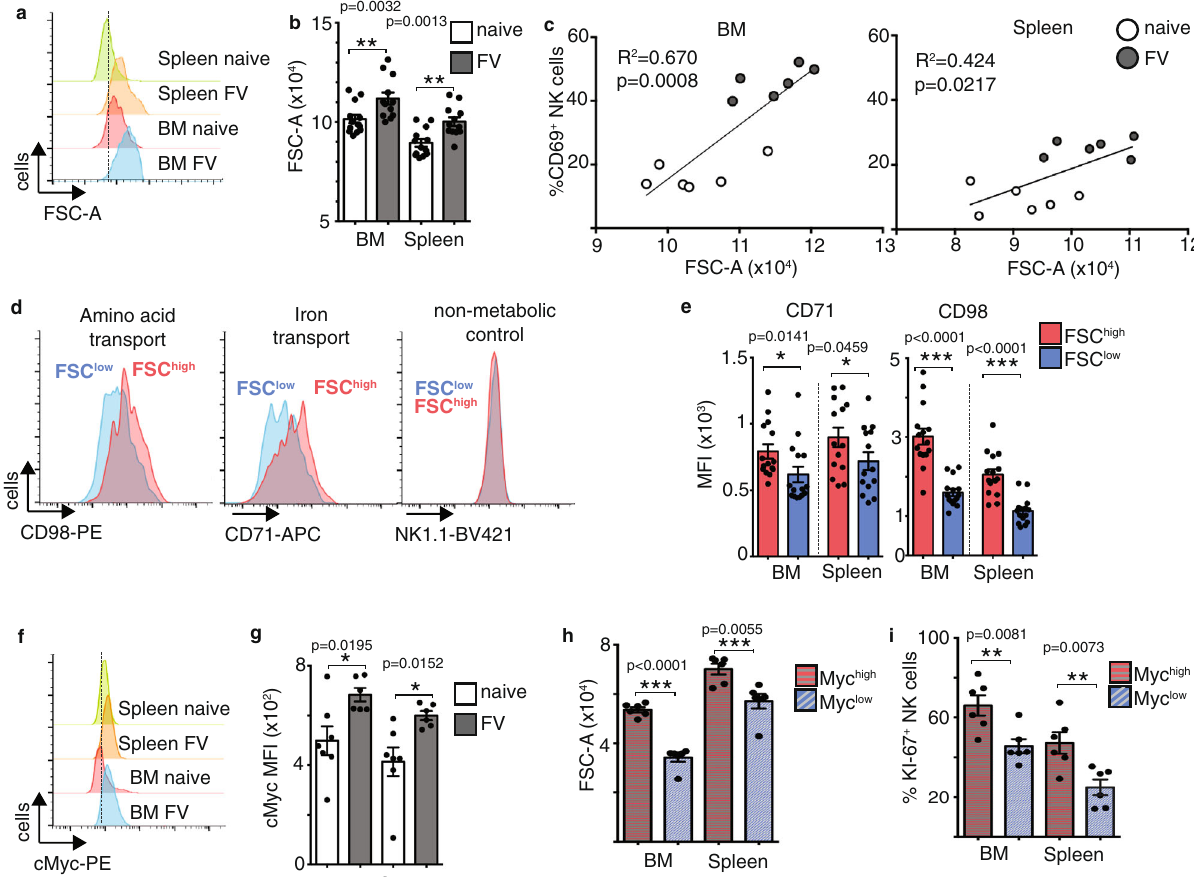
Fig. 2 Increased NK cell blastogenesis and augmented metabolic activity after acute FV infection. Splenic and bone marrow (BM) NK cells from naive mice or mice FV-infected for 7 days were analysed for cell size by analysing the FSC on NK cells. NK cells were gated on lymphocytes, single cells, viable, CD3 − , NK1.1 + CD49b + cells. A representative histogram of the FSC on NK cells from both organs are shown in a and displayed as a bar graph ± SEM in b . Statistically signi fi cant differences were analysed between naive and FV groups by a two-tailed unpaired t -test within the bone marrow or spleens. Experiments were repeated independently twice with similar results. The correlation between activated NK cells and NK cell size (FSC-A) was analysed and displayed in c . NK cells from naive mice are displayed in open circles whereas NK cells from FV-infected mice are displayed in grey circles. At least six mice per group from two independent experiments were used. FSC high and FSC low NK cells were analysed for the expression of CD98 and CD71 ( d ). NK1.1 expression was analysed on FSC high and FSC low NK cell population ( d , right-hand side). Experiments were repeated independently twice with similar results. Differences between FSC high and FSC low NK cells regarding CD71 and CD98 are shown in a bar graph in e . At least 14 mice from four independent experiments were used for the analysis. Statistically signi fi cant differences between FSC high and FSC low NK cells were analysed with a two-tailed Mann – Whitney test within the bone marrow or spleens. Data are presented as mean values ± SEM. Representative histogram of cMyc of NK cells in the spleen and bone marrow are shown in f. Experiments were repeated independently twice with similar results. The MFI of cMyc on NK cells ( g ) is displayed as bar graphs ± SEM and were analysed by a two-tailed unpaired t -test. At least six animals from two independent experiments were used for the analysis. cMyc + and cMyc − NK cells were further analysed for the cell size by measuring the FSC ( h ) and for proliferation by detecting KI-67 ( i ). At least six mice per group from two independent experiments were used. Data are presented as mean values ± SEM. Statistically signi fi cant differences in bone marrow or spleen were analysed with a two-sided unpaired t -test and displayed as * p < 0.05, ** p < 0.01, *** p < 0.001. Source data are provided as a Source Data fi